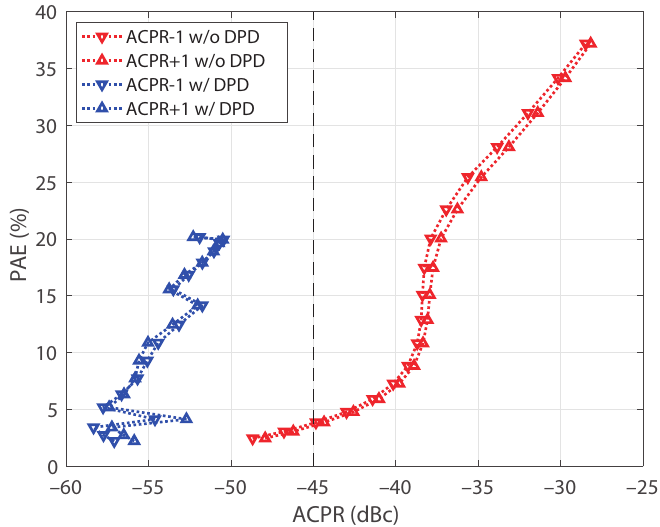
Figure 13. Relationship between PAE and ACPR, without and with